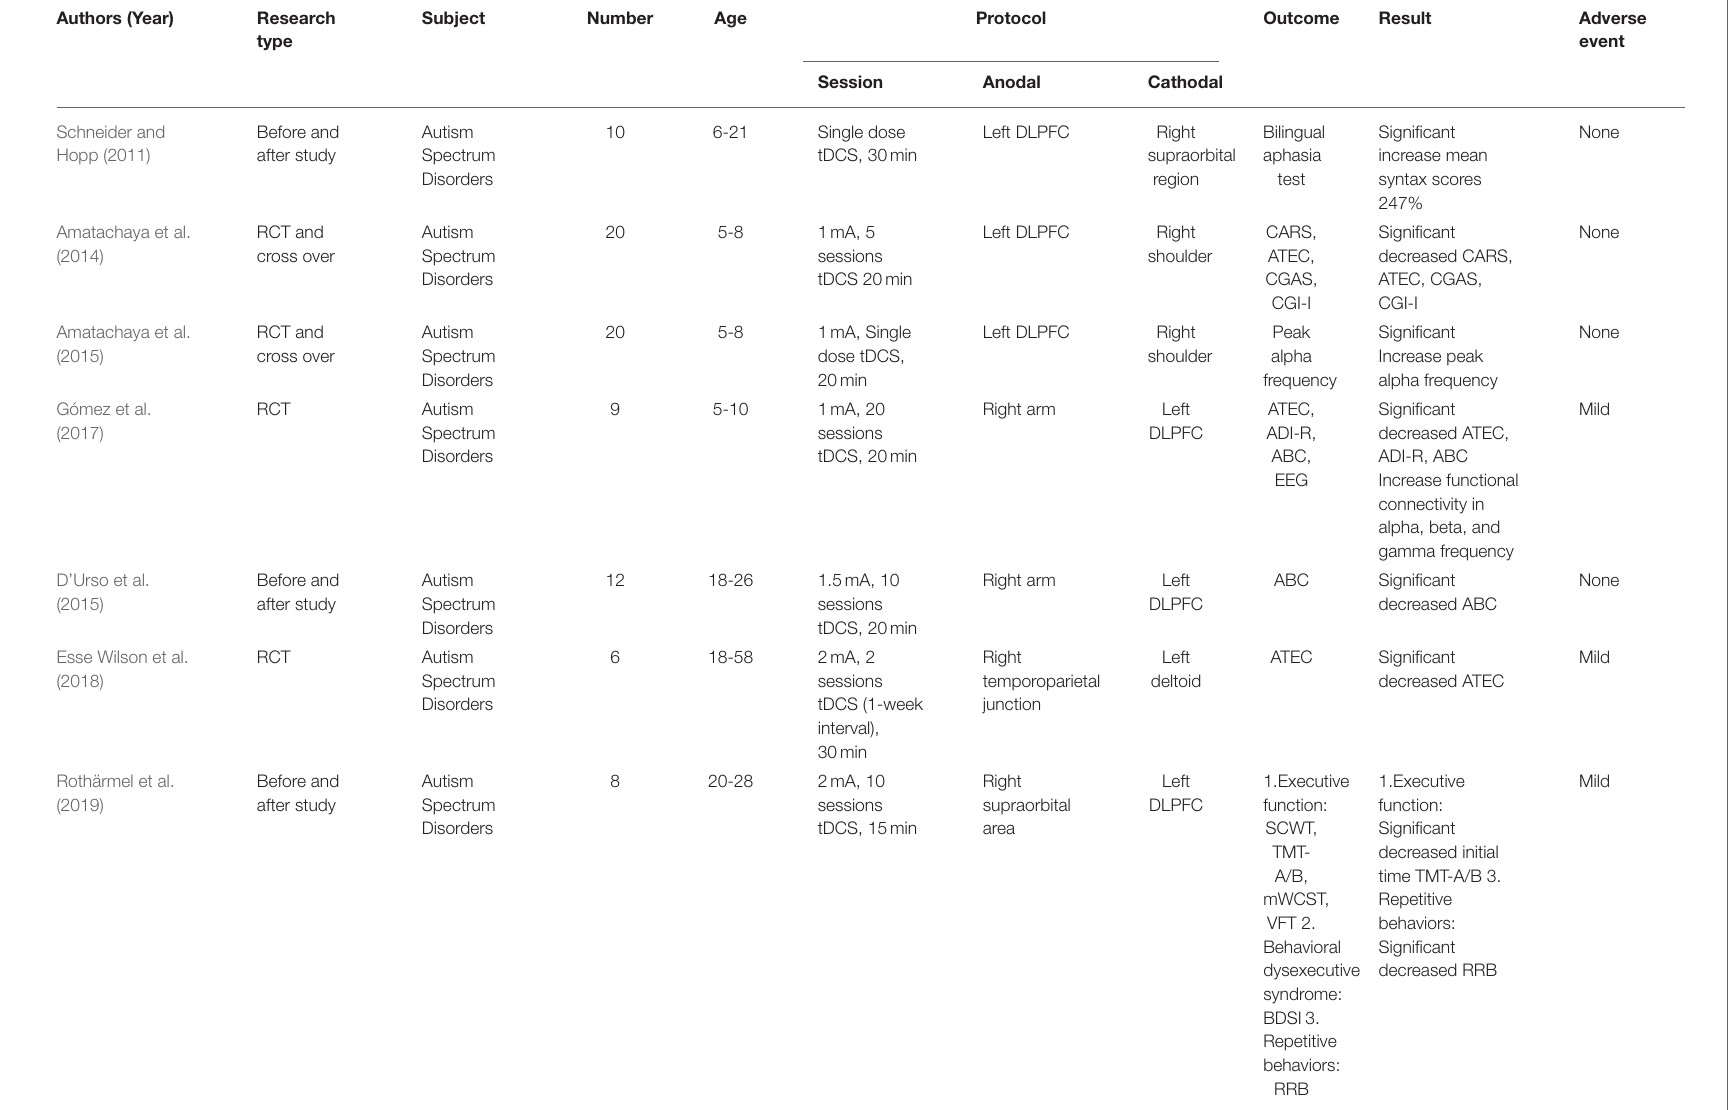
TABLE 2 | Summarized tDCS’ clinical outcomes and adverse events in children with neuropsychiatric